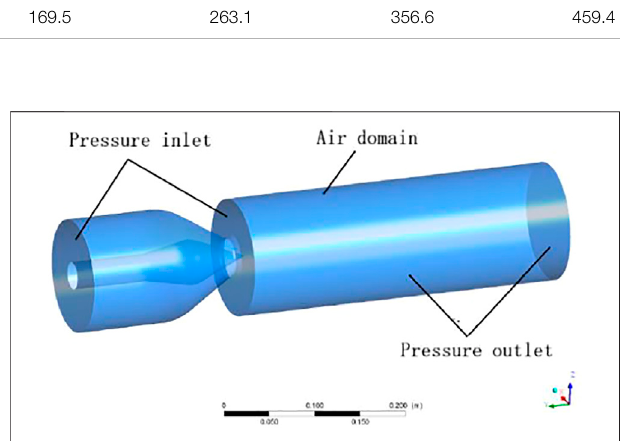
FIGURE 3 | Model boundary condition setting.